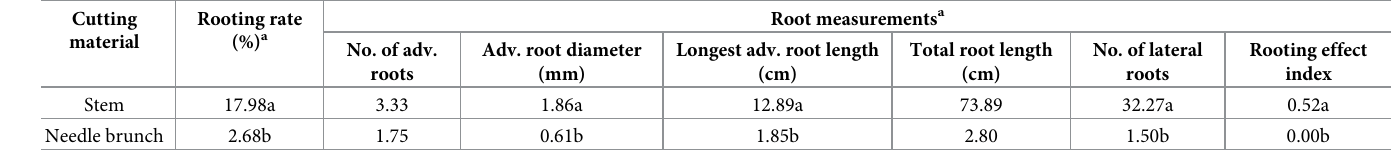
Table 3. Effect of the cutting material on rooting rate and other root related traits of PWD resistant stem cuttings. Cutting Rooting rate material (%)